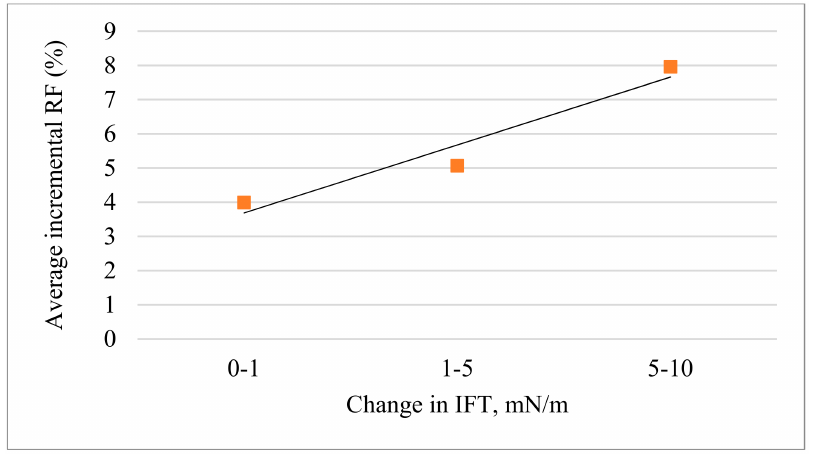
Figure 9. Average incremental RF vs. Change in